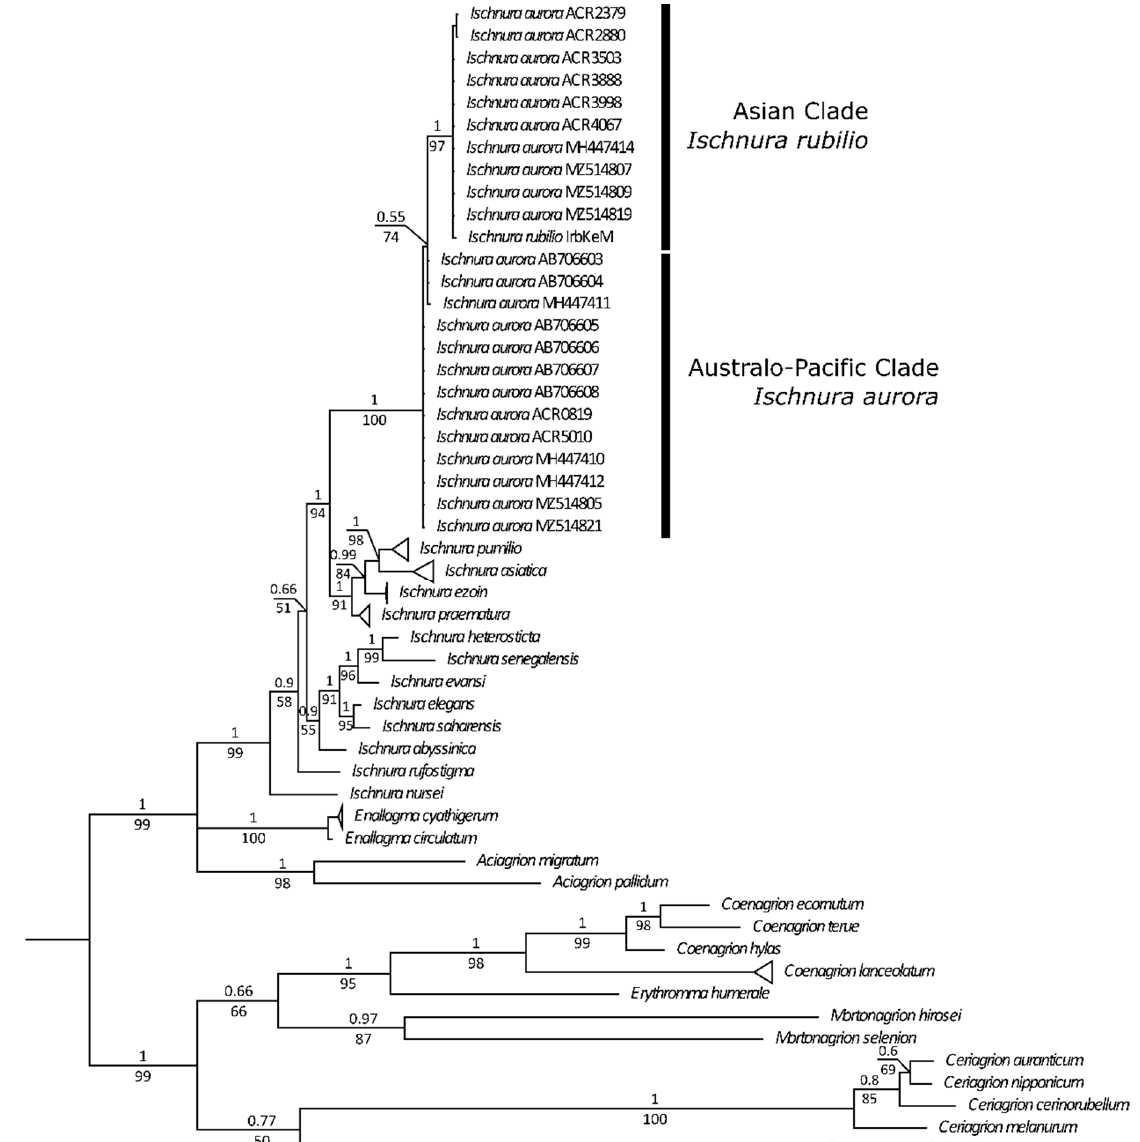
Figure 3. Tree representing the phylogenetic relationships among the Ischnura species analysed in this study, using nuclear DNA ( ITS ) sequence data. Numbers above and below branches represent Bayesian posterior probability and maximum likelihood bootstrap values, respectively. Clades are labelled according to the ASAP proposed species delimitation (see also Table A1 and Figure A7b).